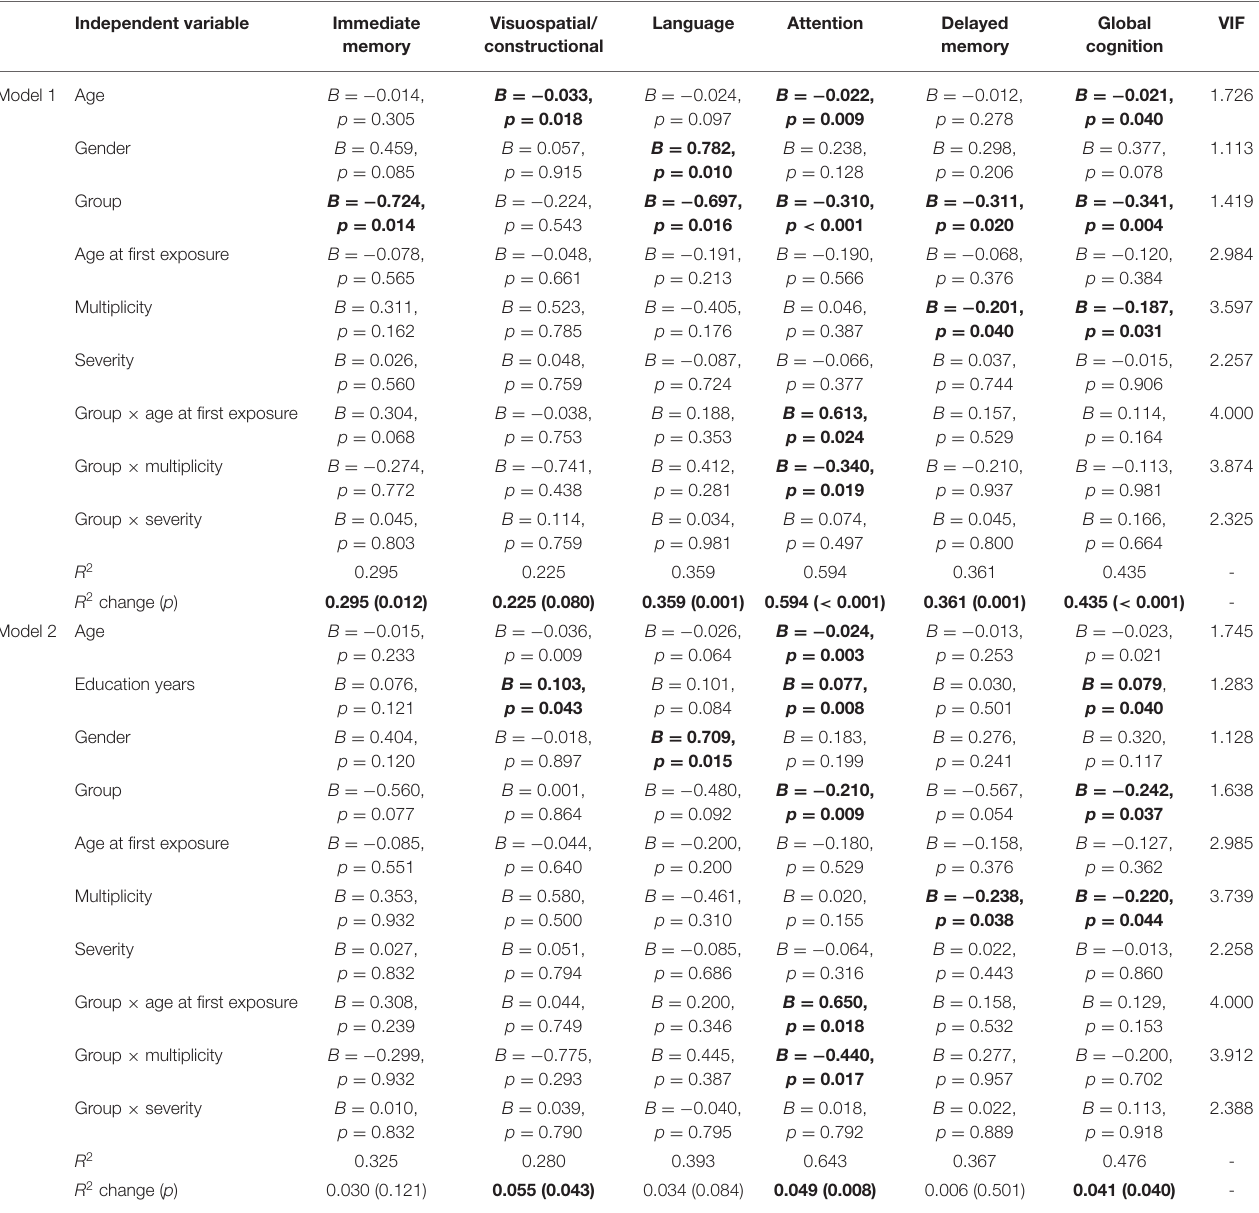
TABLE 3 | Results of linear regression